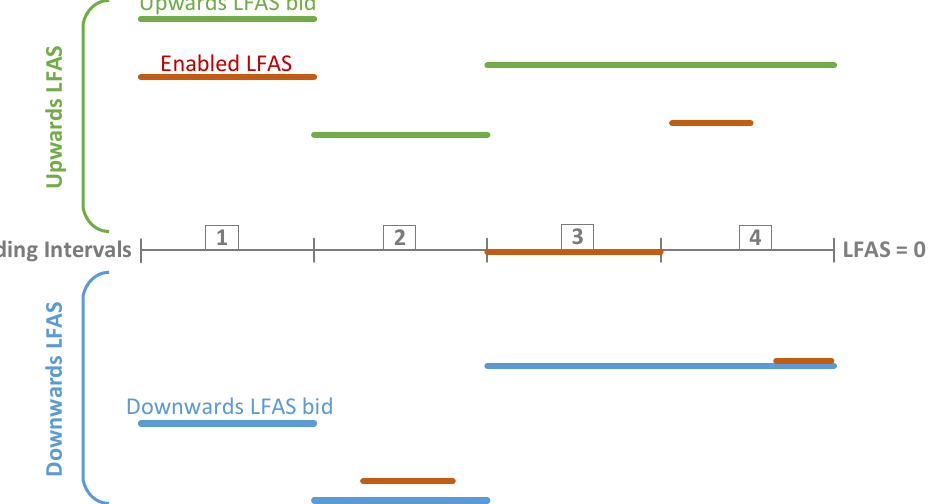
Figure 1. An example of LFAS bidding and enablement over four trading intervals. Green: bidding power for upwards LFAS; Blue: bidding power for downwards LFAS; Brown: the enabled power by AGC. Numbers 1 to 4 are representing the trading intervals.